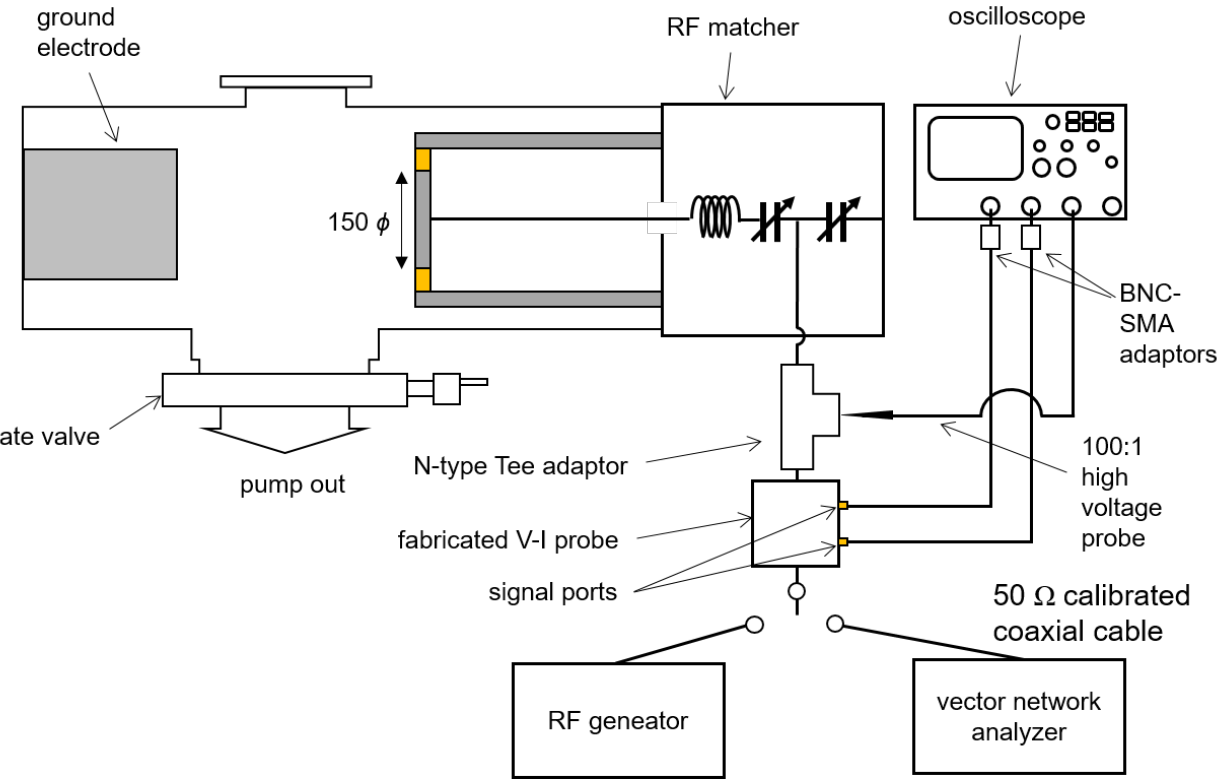
Figure 8. Schematic diagram of the calibration setup for the fabricated FTC-based VI probe. The fabricated VI probe is installed on the input port of the RF matcher with the N-type Tee adaptor. The two signal ports of the fabricated VI probe are connected to channel 1 and 2 of an oscilloscope through coaxial cables with BNC-SMA